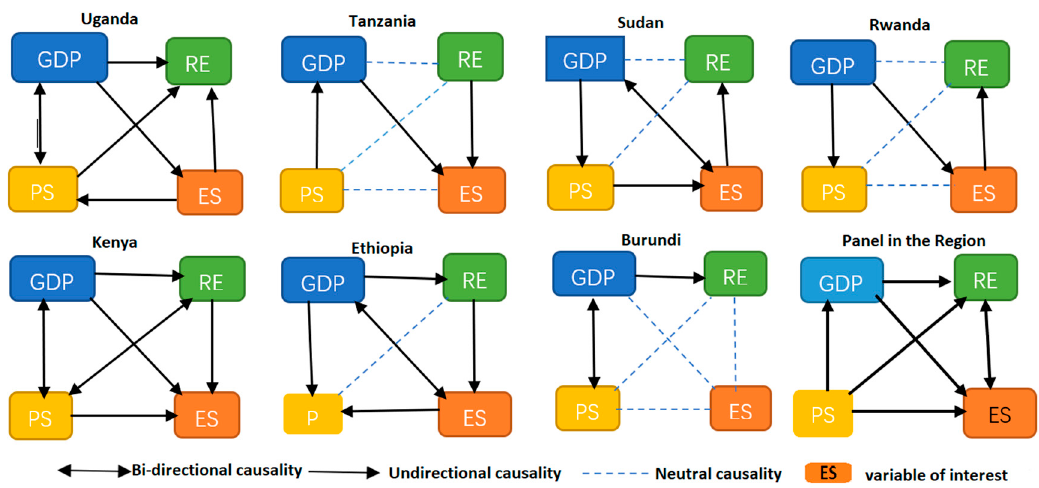
Figure 4. Graphical representation of hypotheses results.